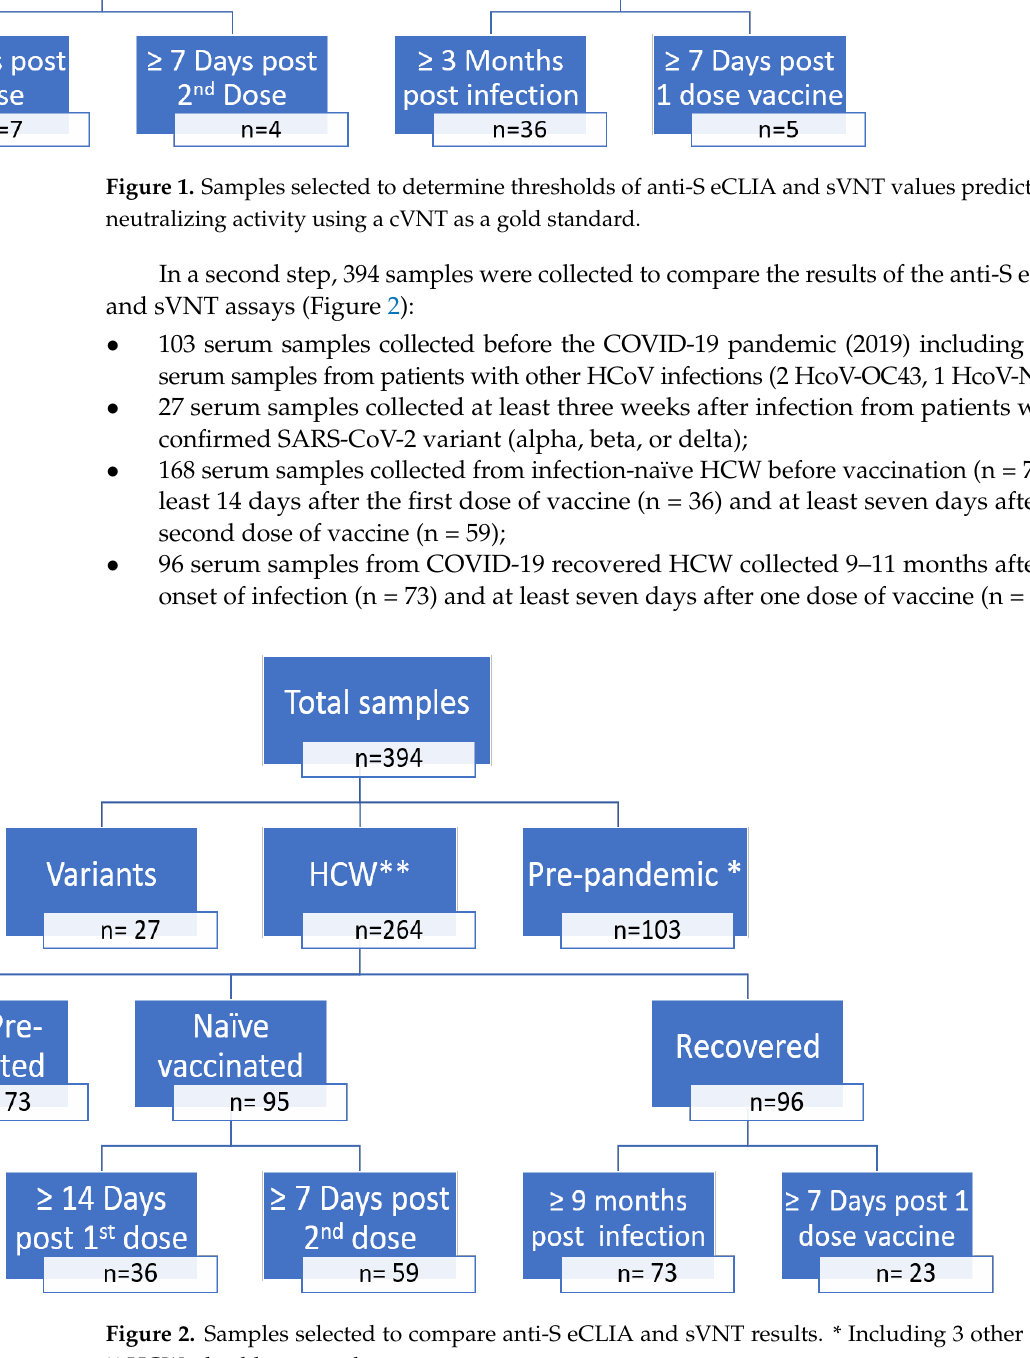
Figure 2. Samples selected to compare anti-S eCLIA and sVNT results. * Including 3 other HcoV, ** HCW—healthcare